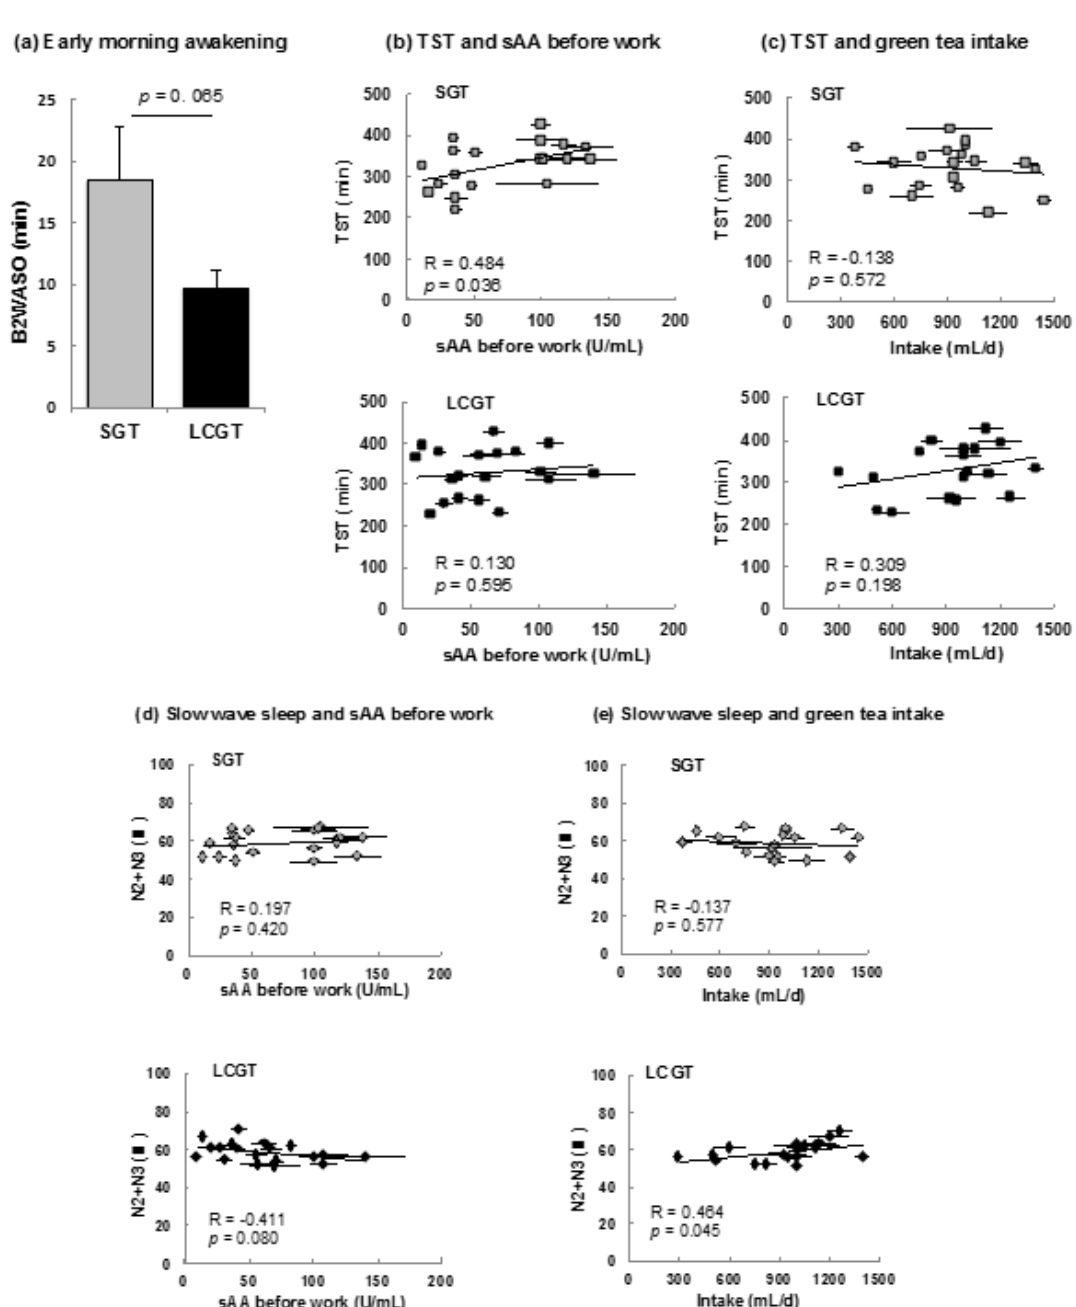
Figure 4. Effect of green tea intake on sleep parameters or sAA. ( a ) Early morning awakening. Data are expressed as mean ± SEM ( n = 19, *, p = 0.065; one-way ANOVA); ( b ) Correlation between TST and sAA before work; ( c ) Correlation between TST and intake volume; ( d ) Correlation between slow wave sleep (N2+N3) and sAA before work; ( e ) Correlation between slow wave sleep and intake of SGT or LCGT. Data of b–e are expressed as mean ± SEM ( n = 5, in each